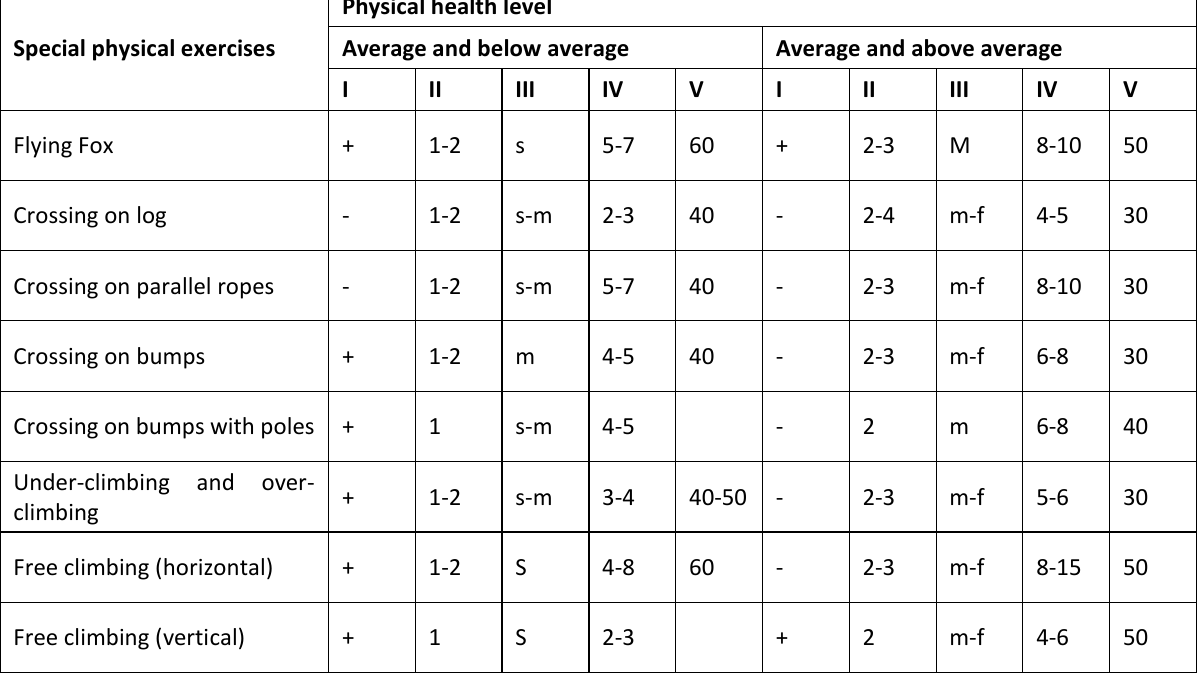
Table 1. Parameters of physical loads during fulfillment of special physical exercises by children with different PHL Special physical